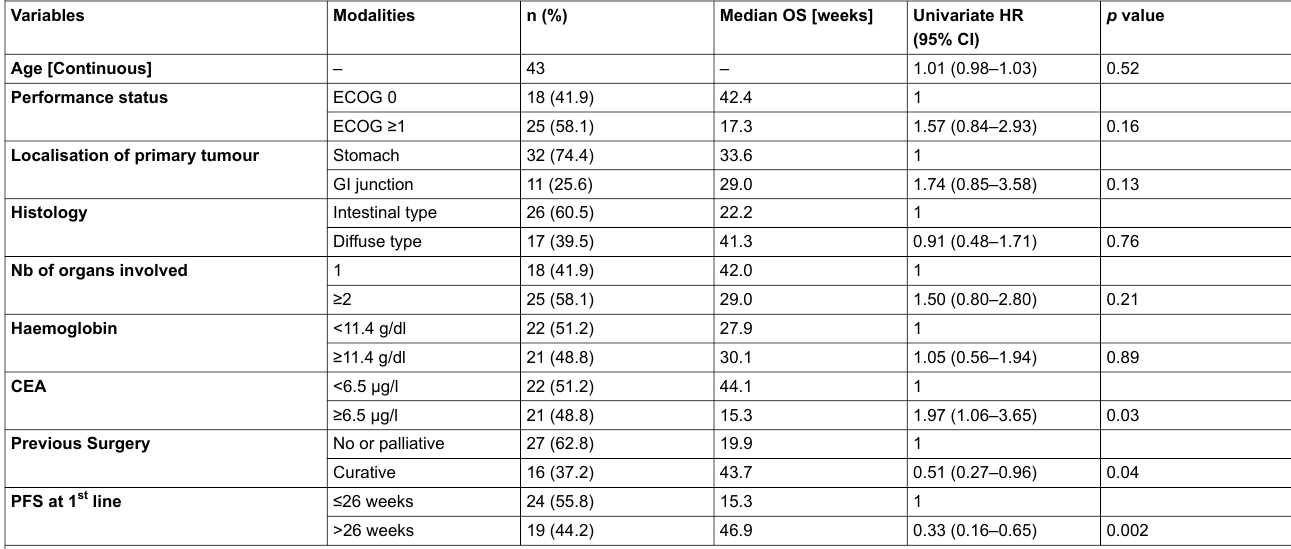
Table 4: Univariate analysis (Cox regression) to test association between patient characteristics and overall survival (n = 43).